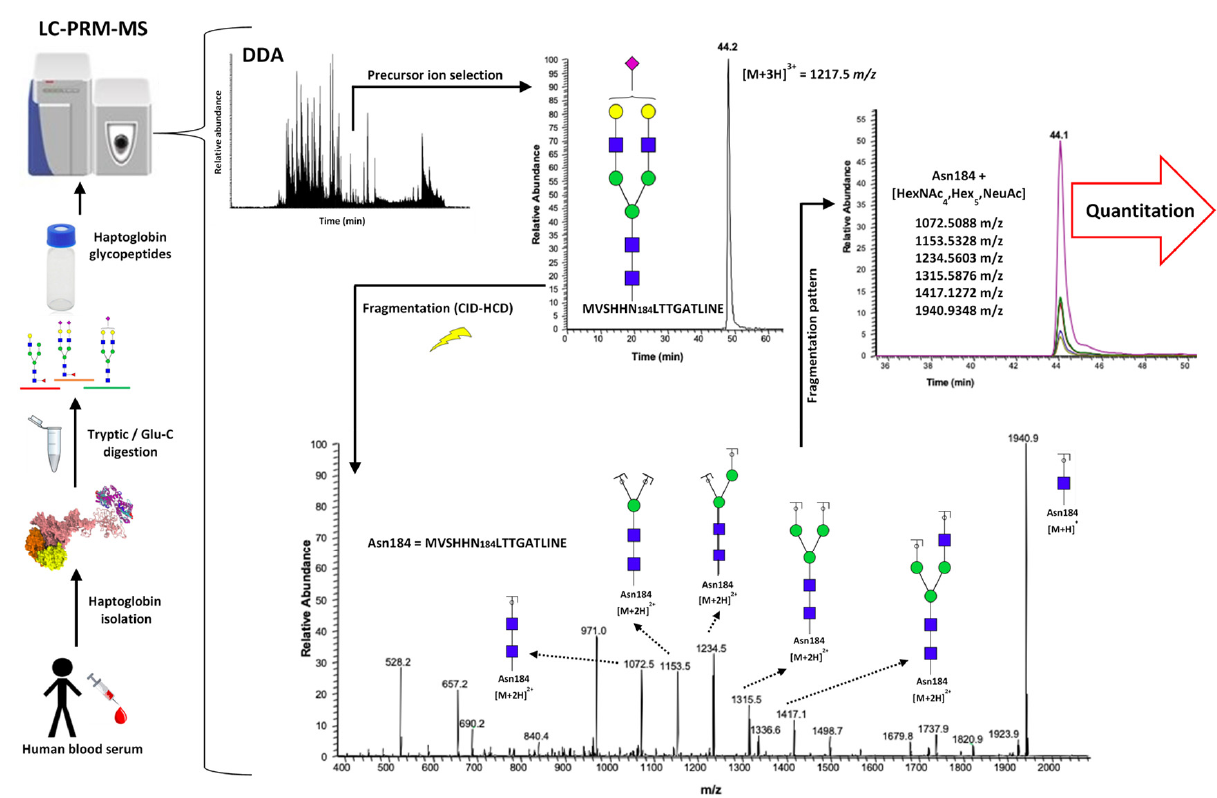
Figure 1. Workflow for the parallel reaction monitoring mass spectrometry (PRM-MS) analysis of serum haptoglobin N- glycopeptides.